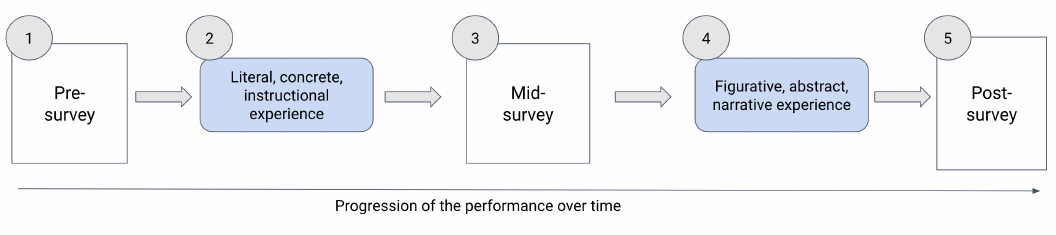
Figure 2: The experiment design illustrated from beginning to end. Three surveys were used through the performance to collect audience perceptions. Integrating the activity of filling out the surveys with the performance helped increase the number of responses and allowed for more points of feedback from audience members. Here, the first part of the performance is more concrete and literal than the abstract contemporary dance style used in the second part. This first section is used to homogenize the audiences’ understanding of vocabulary used in the study and point out subtleties about system